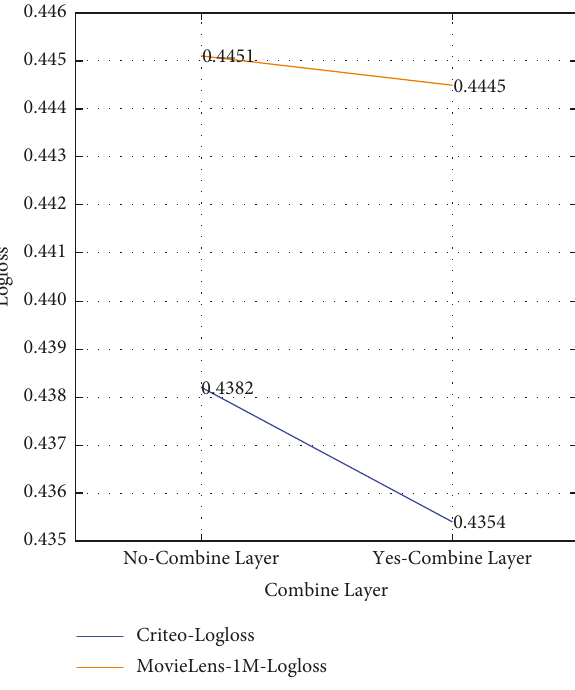
Figure 12: The classification gate of Logloss in model CCPIN.